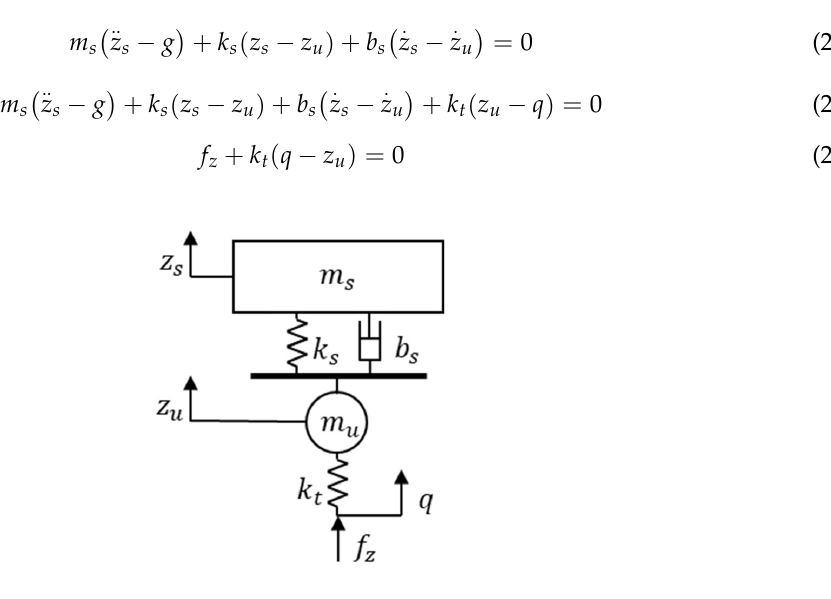
Figure 12. Quarter car model for normal force calculation.